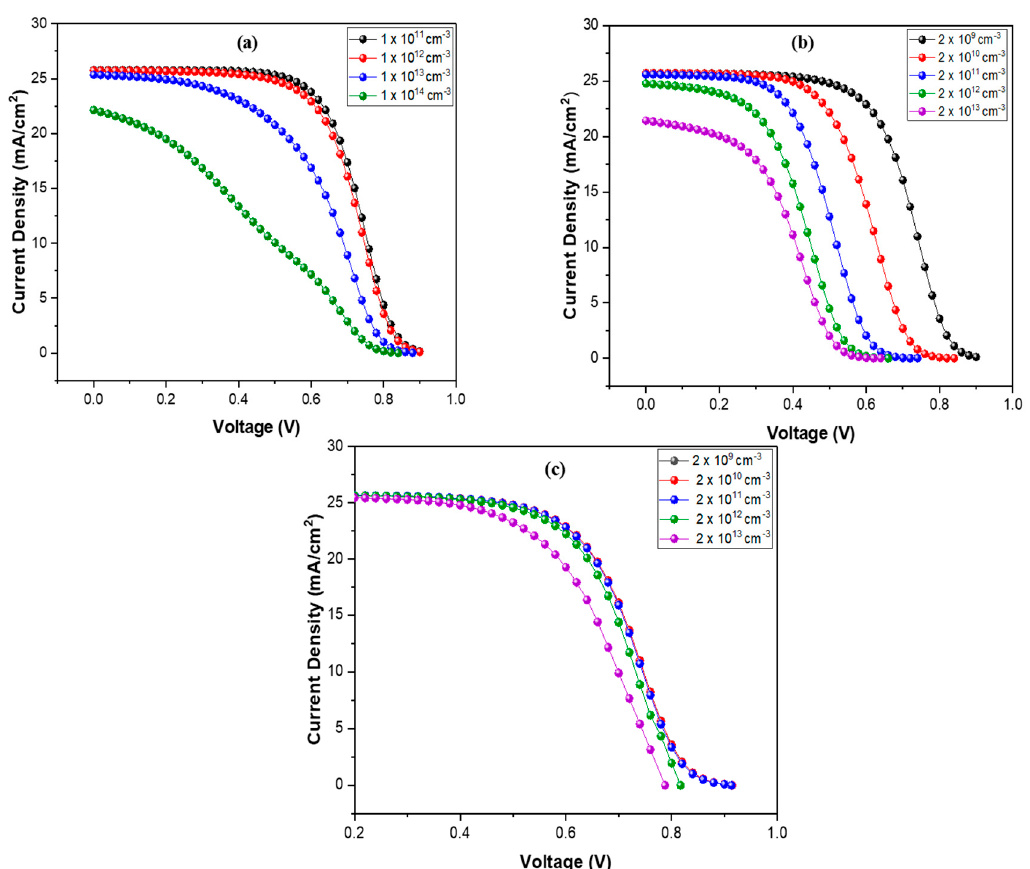
Figure 5. ( a ) Current-density comparison at various defect densities of the absorber layer; ( b ) current-density comparison at various defect densities of IL1; and ( c ) current-density comparison at various defect densities of IL2.